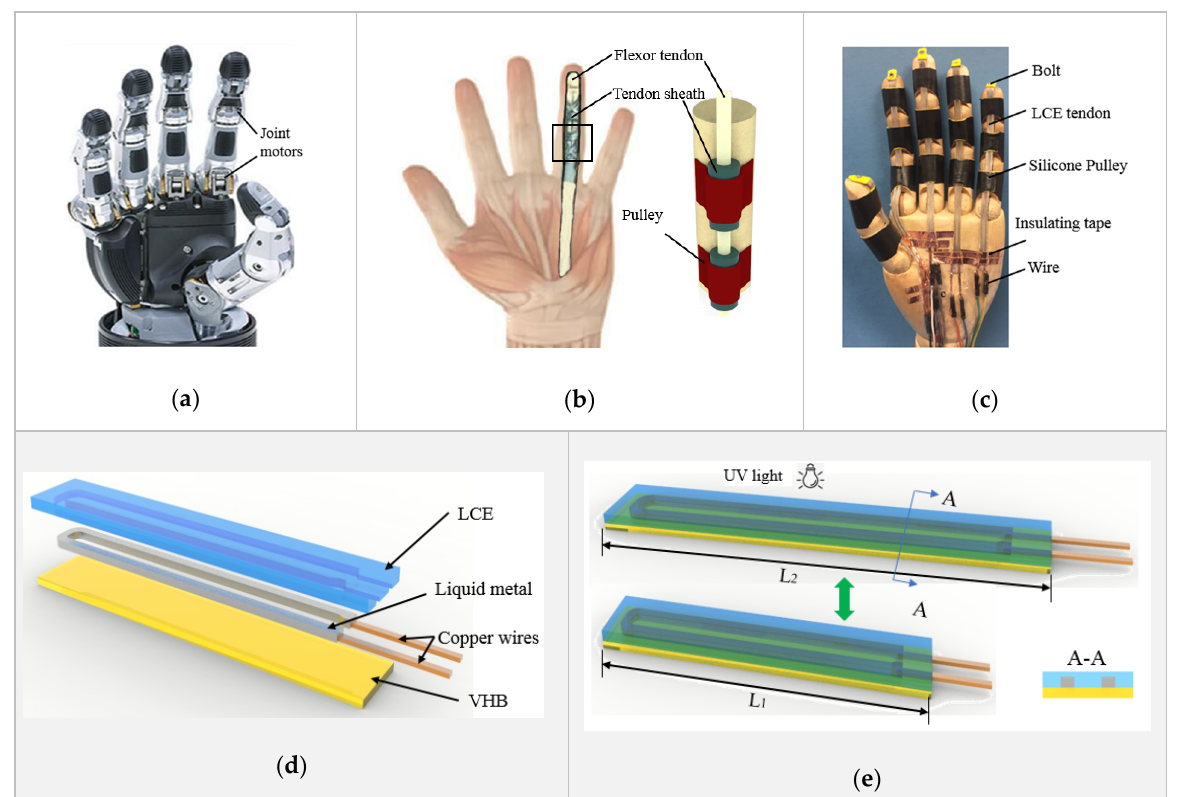
Figure 1. Design and fabrication of LCE tendon and biomimetic prosthetic hand. Comparison of the design and structure between ( a ) a robot hand [1], ( b ) a human hand [87], and ( c ) the biomimetic prosthetic hand. ( d ) The design and multilayer structure of the LCE tendon. ( e ) Programming of the LCE tendon during fabrication process.